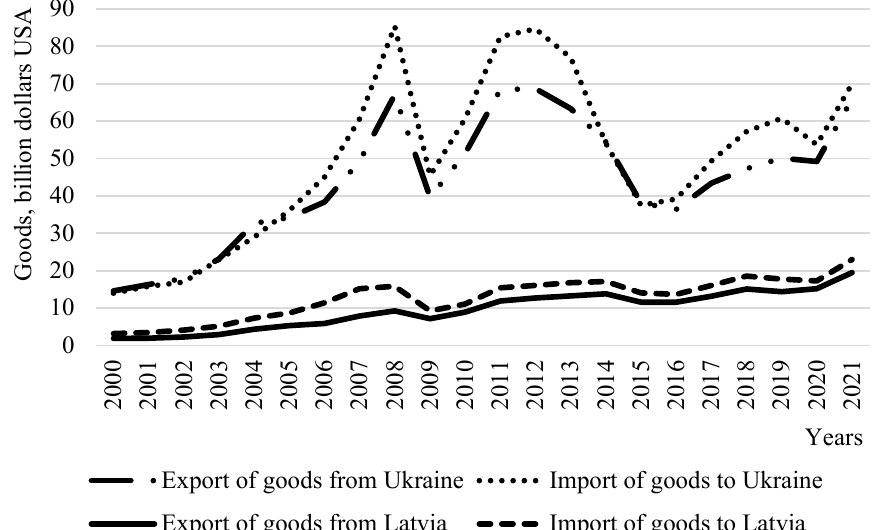
Fig. 1. International merchandise trade of Ukraine and Latvia with the countries of the world: export and import of goods in 2000–2021 (United Nations,